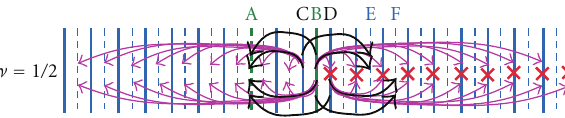
Figure 23: Electron configuration in excited state #3 at ν = 1 /